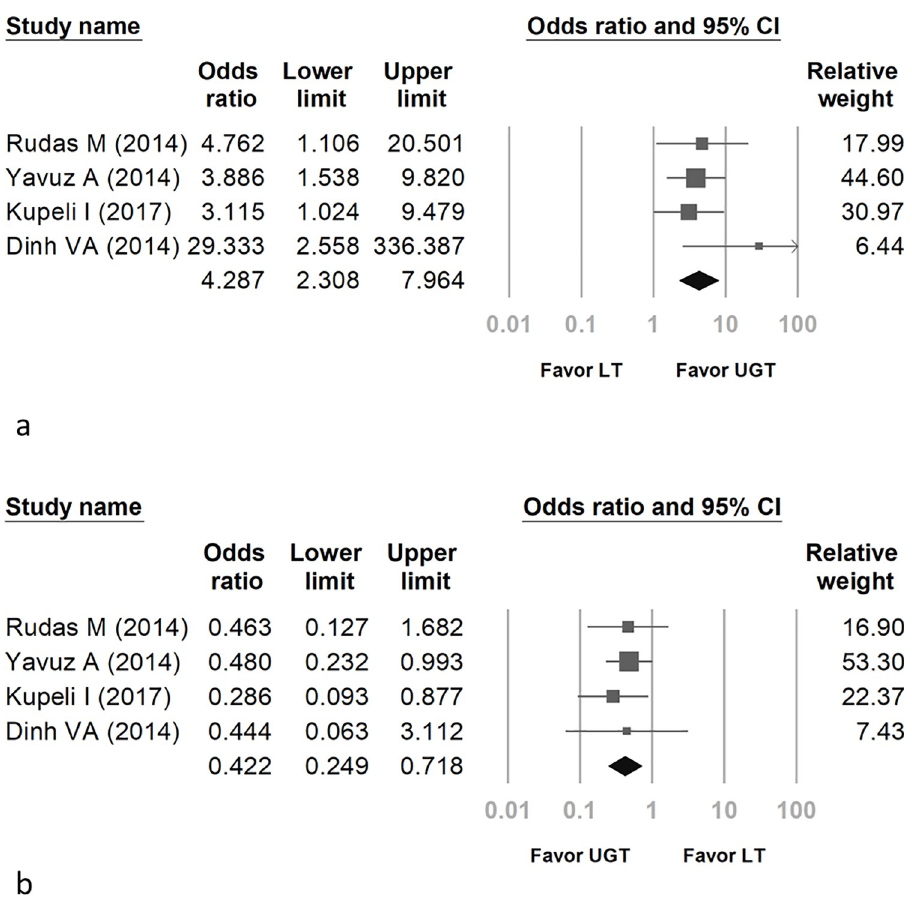
Fig 3. Forest plot comparing real-time UGT with LT for first-pass success (a) and complications